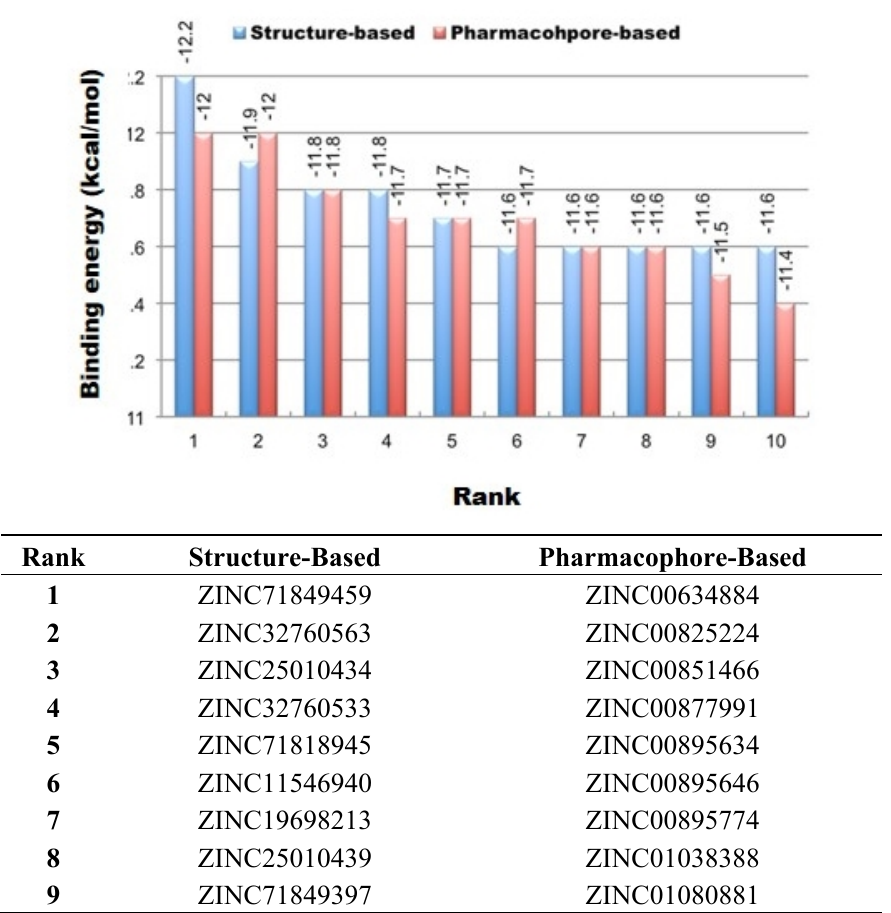
Figure 6. The top 10 ranked ZINC compounds from both the 2D similarity-based and pharmacophore-based libraries.